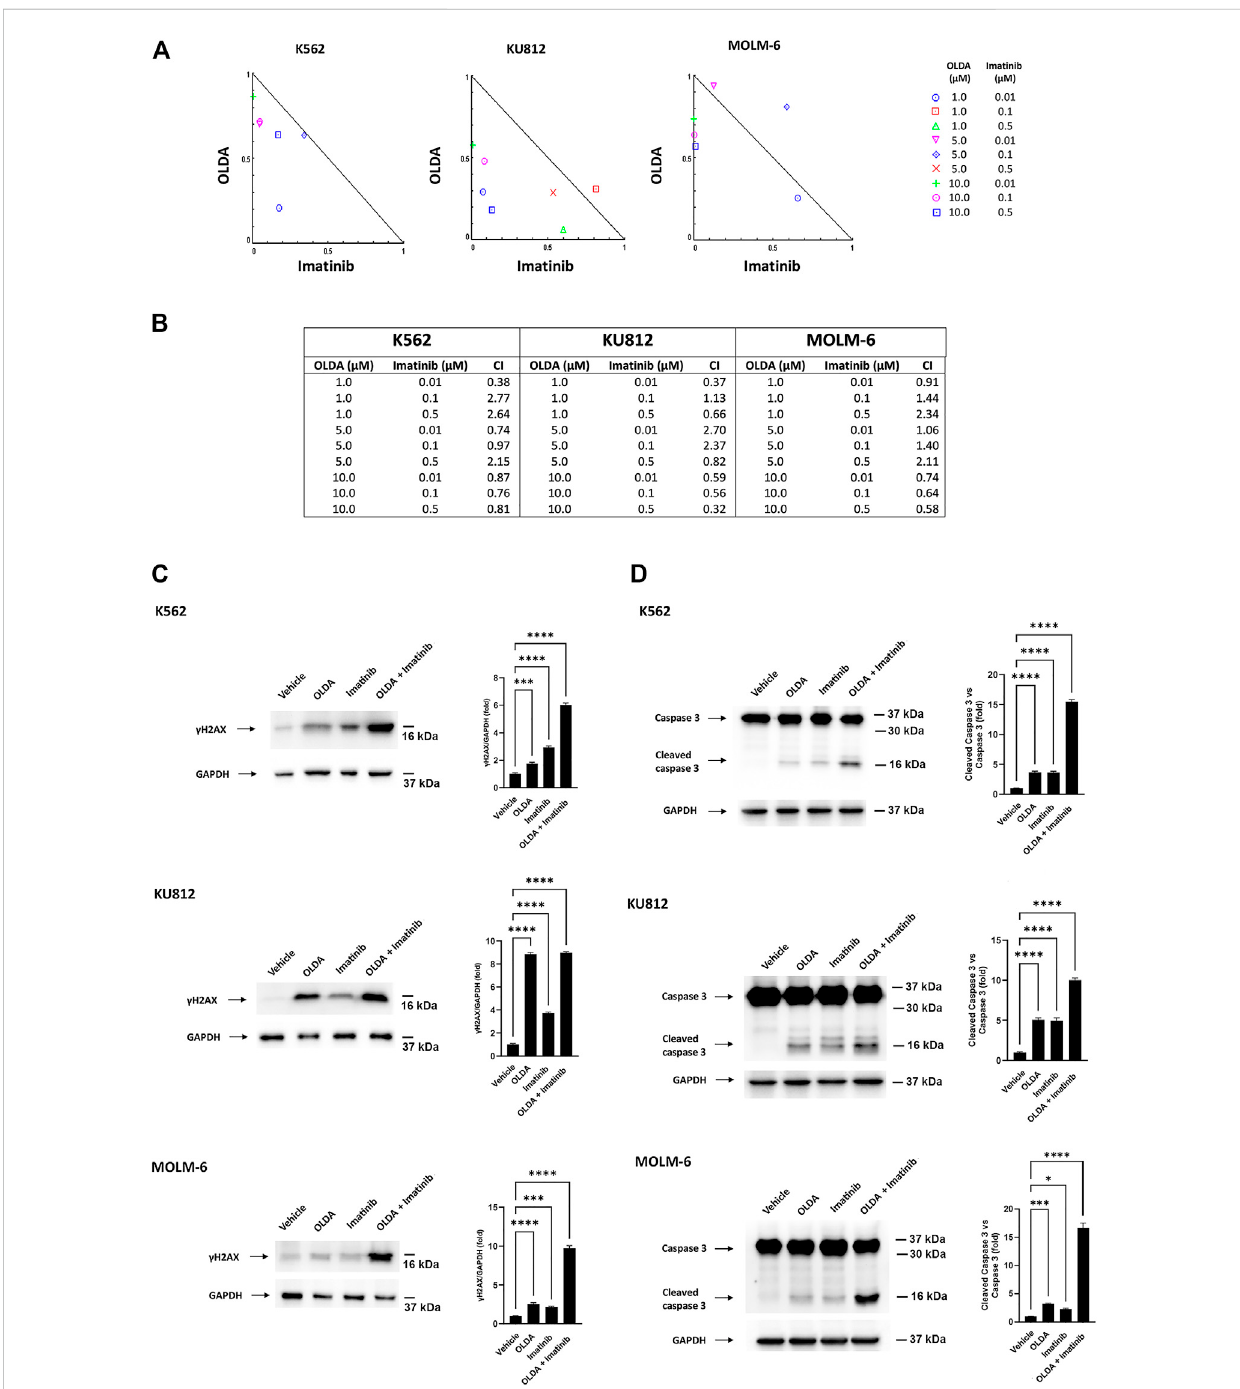
OLDA and imatinib synergize in reducing cell viability. (A) Isobologram plots for combination treatments of OLDA and imatinib. Lower left of the hypotenuse, synergism; hypotenuse, additive effect; upper right of the hypotenuse, antagonism. Data are representative of three experiments. (B) CI values obtained using CompuSyn software. Data are representative of three experiments. (C, D) Western blot analysis of γ H2AX (C) and caspase-3 cleavage (D) in CML cells treated for 24 h with the vehicle or with OLDA at the IC 50 dose or imatinib (0.5 μ M), alone or in combination. Blots are representative of three experiments. GAPDH was used as the loading control. Folds (mean ± SD of three experiments) = changes compared to the vehicle. * p < 0.05; *** p < 0.001; **** p <